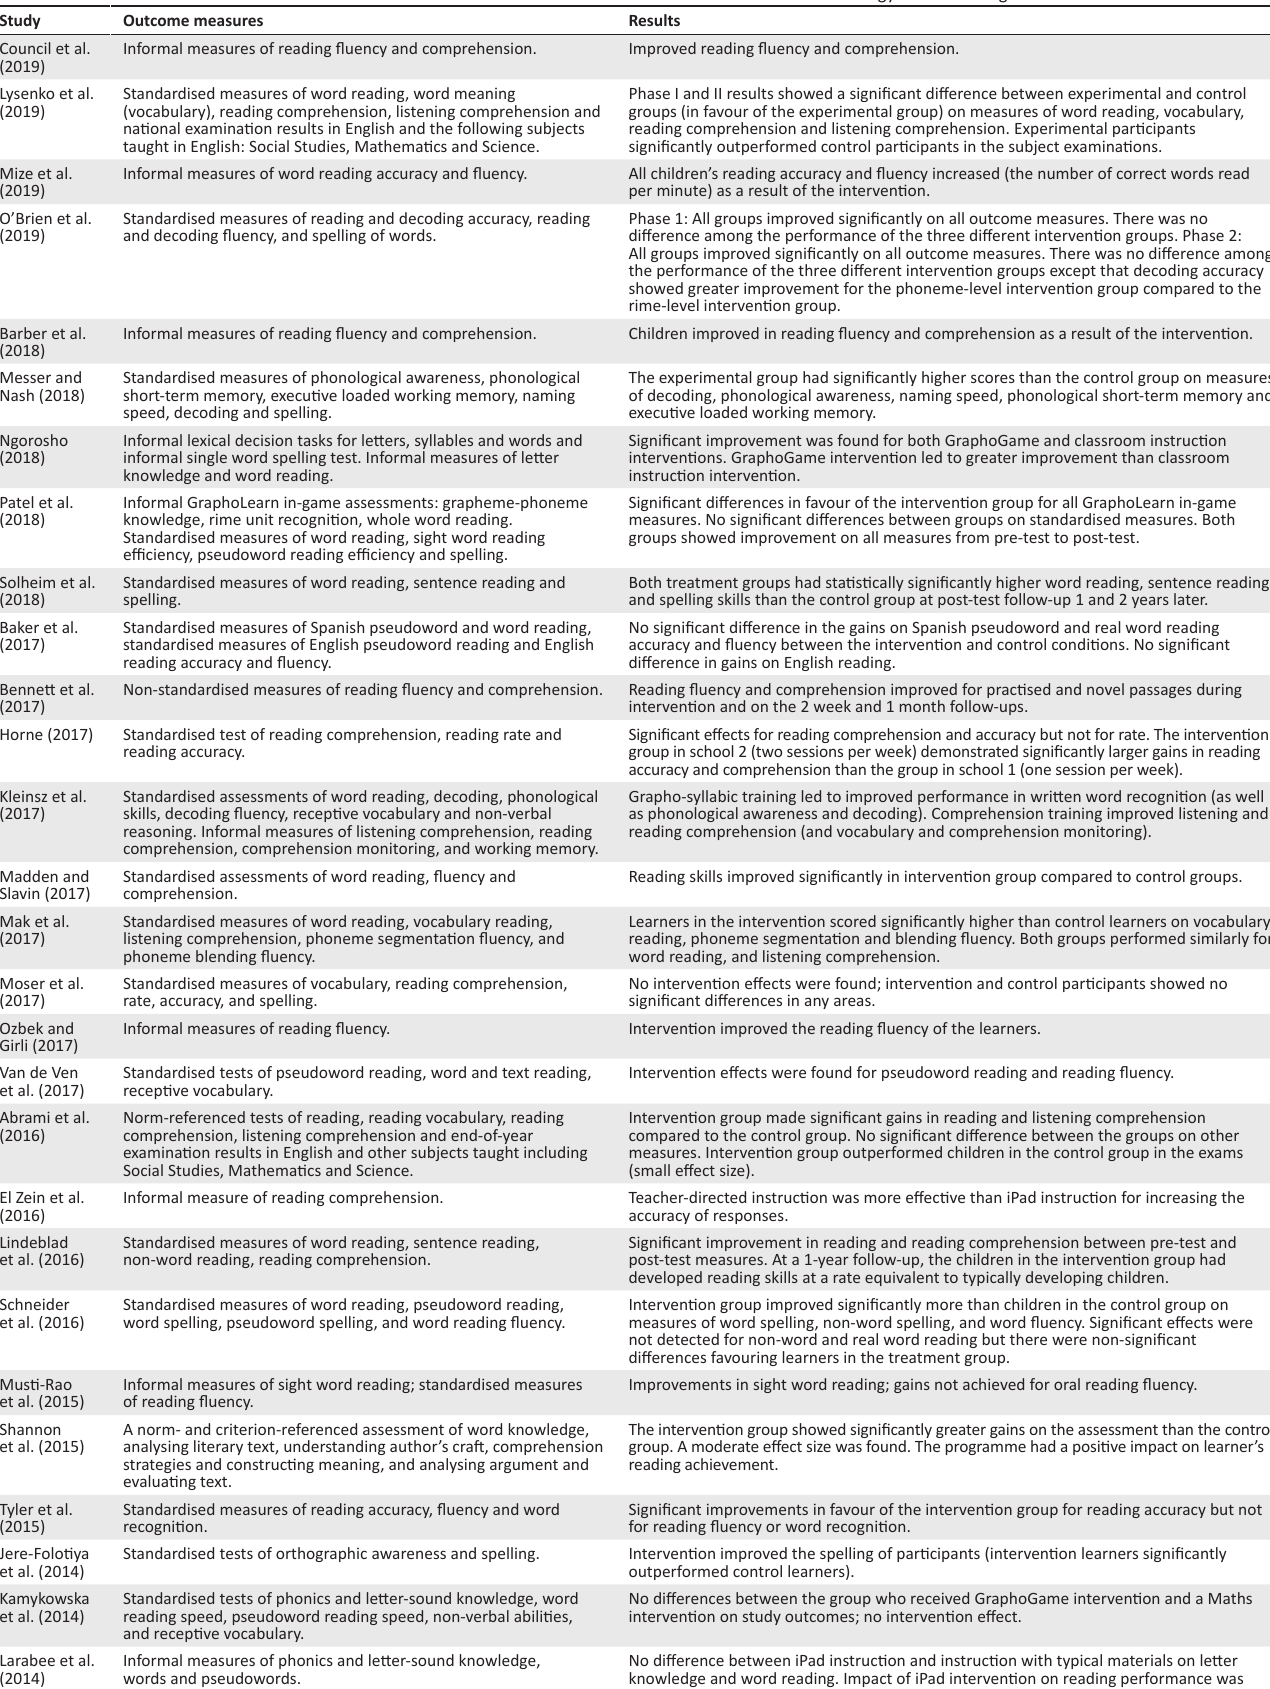
TABLE 3-A1: Outcome measures and results of the studies included in the information and communication technology-based reading intervention literature